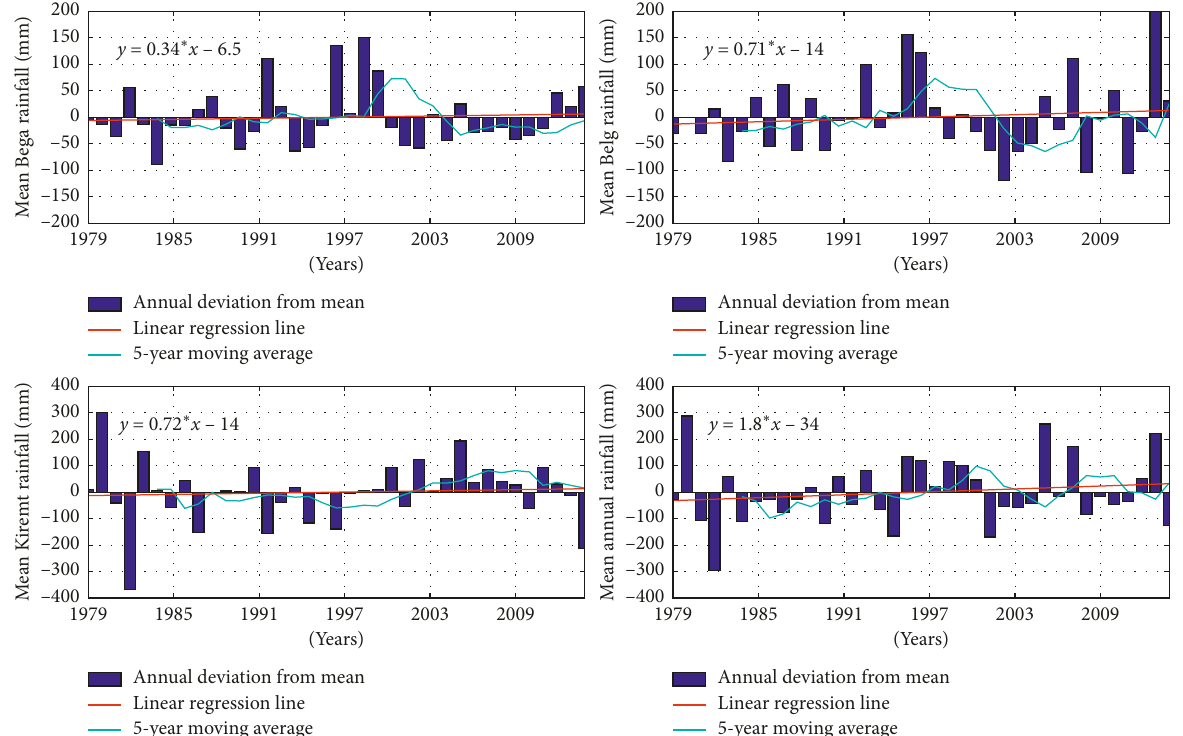
Figure 5: Mean seasonal and annual rainfall and equivalent linear regression trend line and 5-year moving average line plotted for the different aggregated station data sets. (a) Bega. (b) Belg. (c) Kiremt. (d)